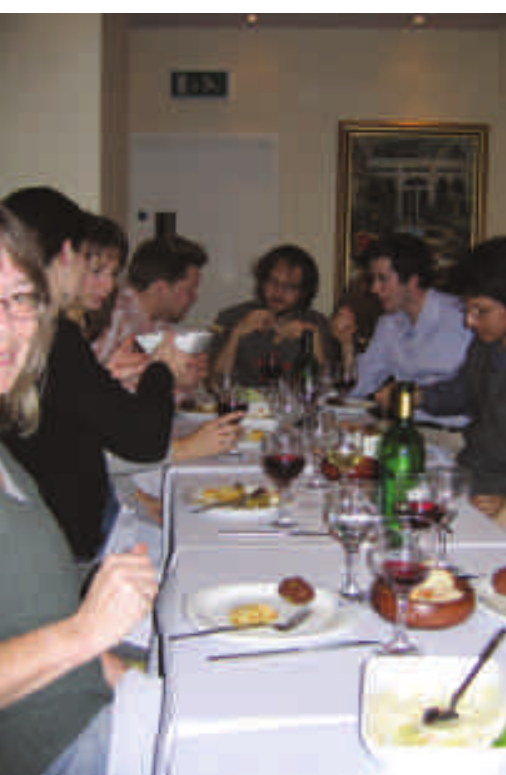
Figure 8 The building inscription under excavation by Cardiff student James Goodsell